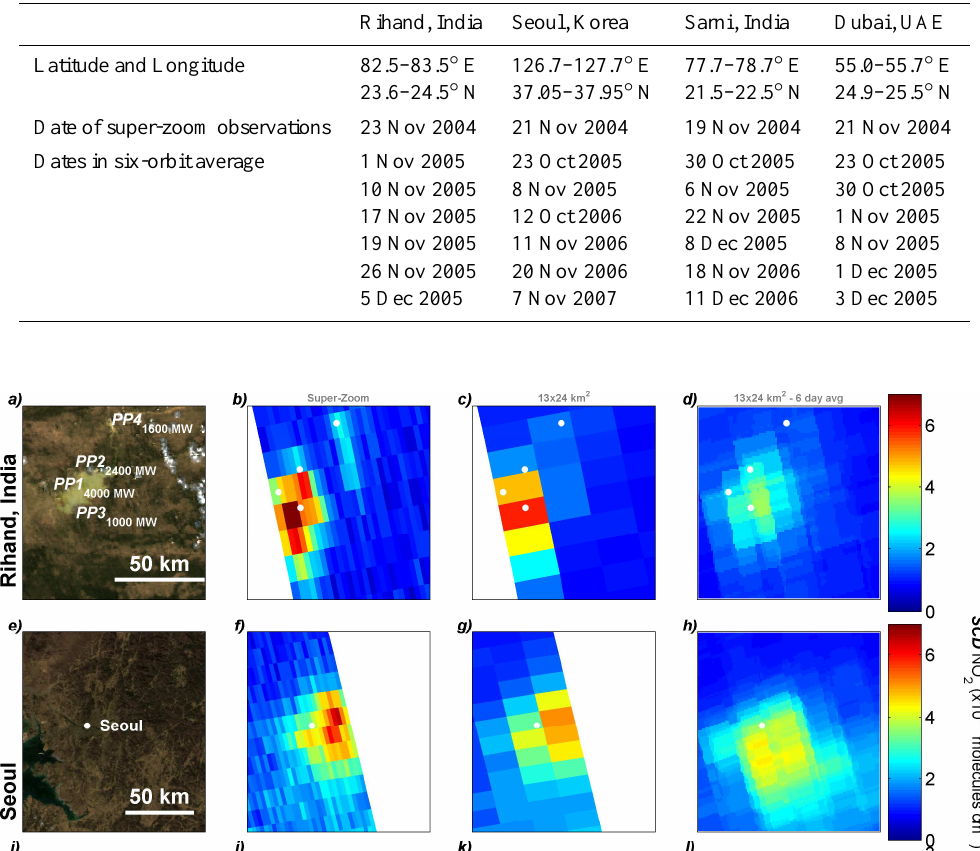
Table 1. Dates and regions for which slant column NO 2 was retrieved.